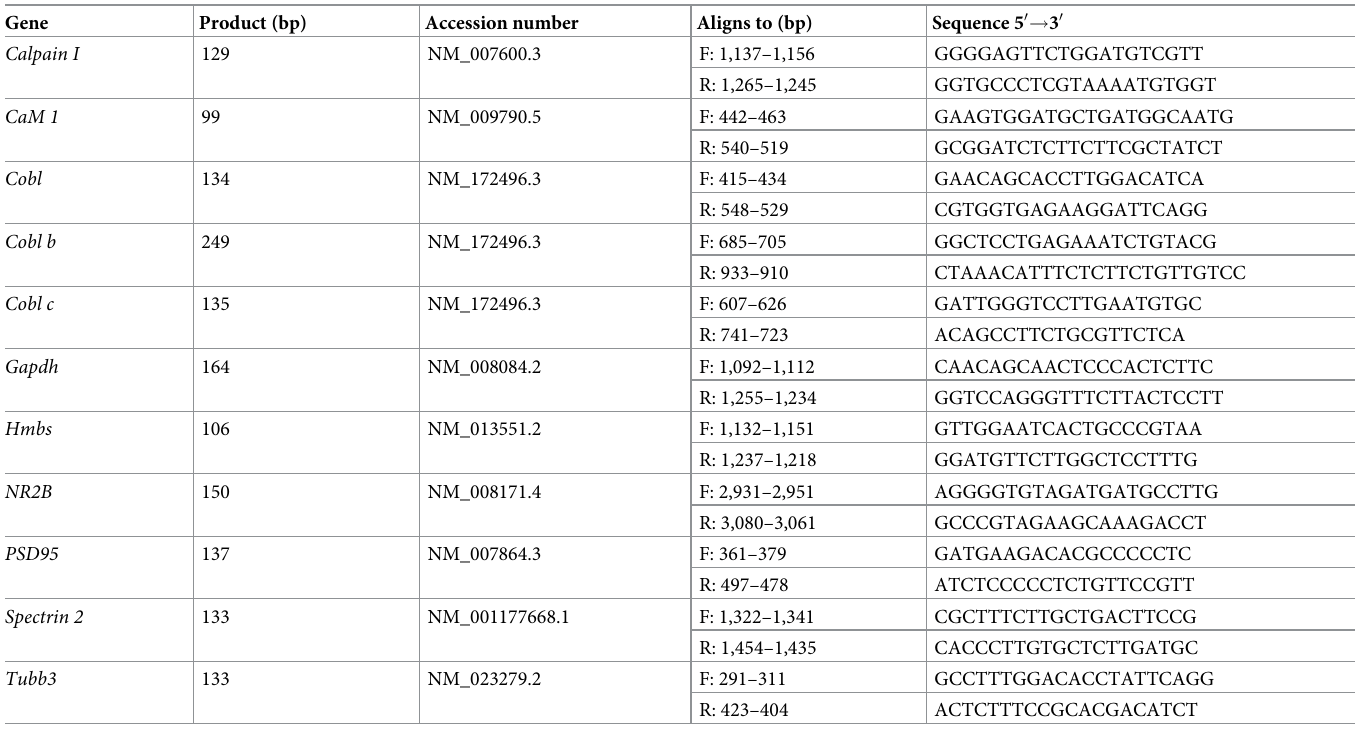
Table 1. qPCR primers used in the